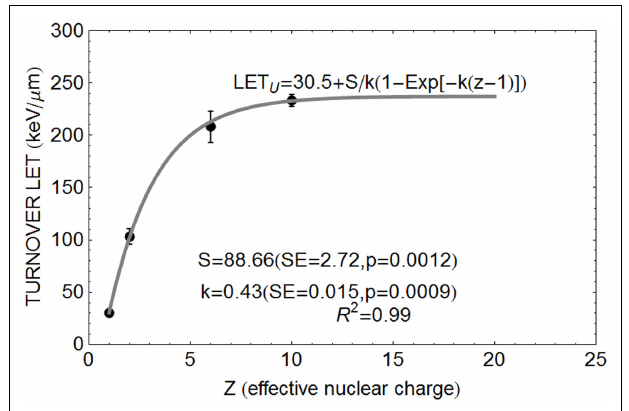
FIGURE 1 | Data points for relationship between Z and turnover point LET value LET U with fitted parameter values based on Eq. (3) .